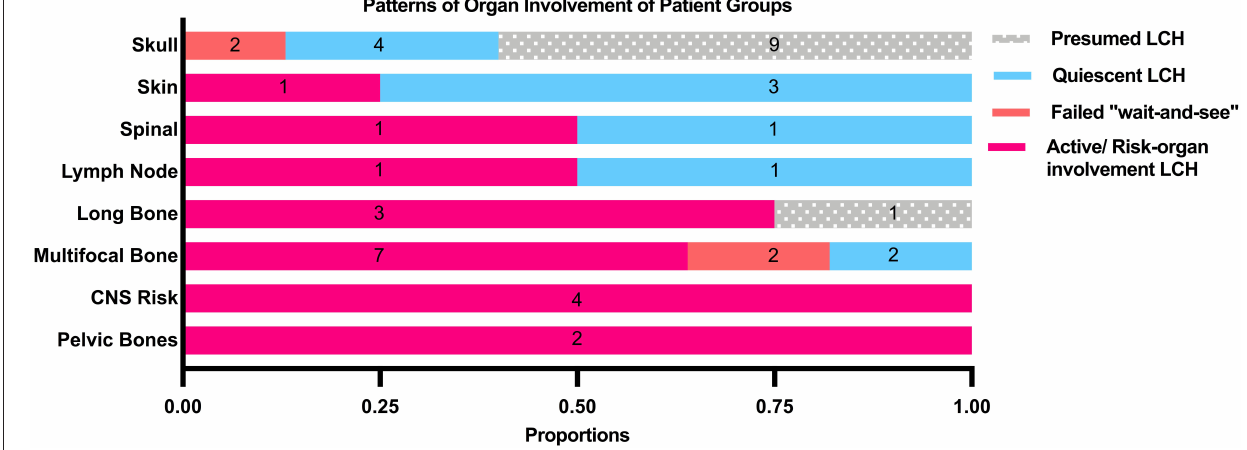
FIGURE 2 | Patterns of organ involvement of the patient groups.